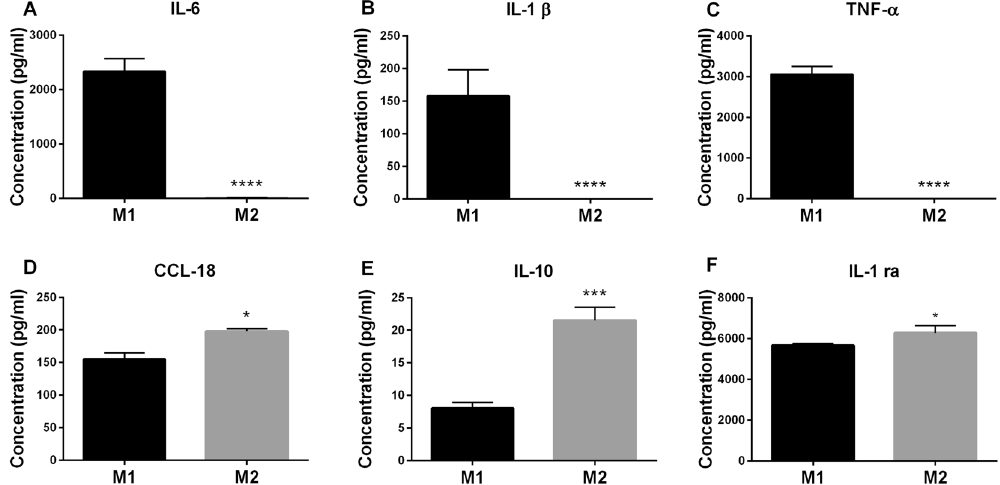
Figure 2. Comparison of cytokine profiles of M1 and M2 macrophages. Cytokines in the supernatants of human monocyte-derived M1 and M2 macrophages cultured for 6 days were measured by means of a bead- based flow cytometric system (for ( A ) IL-6, ( B ) IL-1 β , ( C ) TNF- α ), ELISA (for ( D ) CCL-18), and a bead-based luminex system (for ( E ) IL-10 and ( F ) IL-1RA). Data presented are the mean ± SD of at least 5 independent